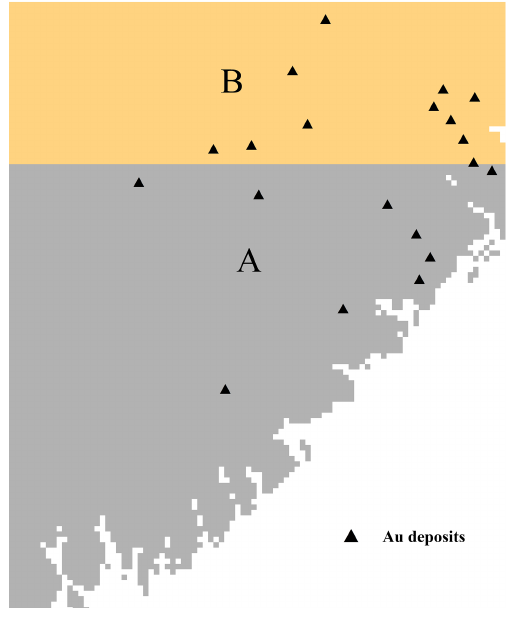
Figure 5. Study area (A and B) where there are missing geochemi- cal data in area B.